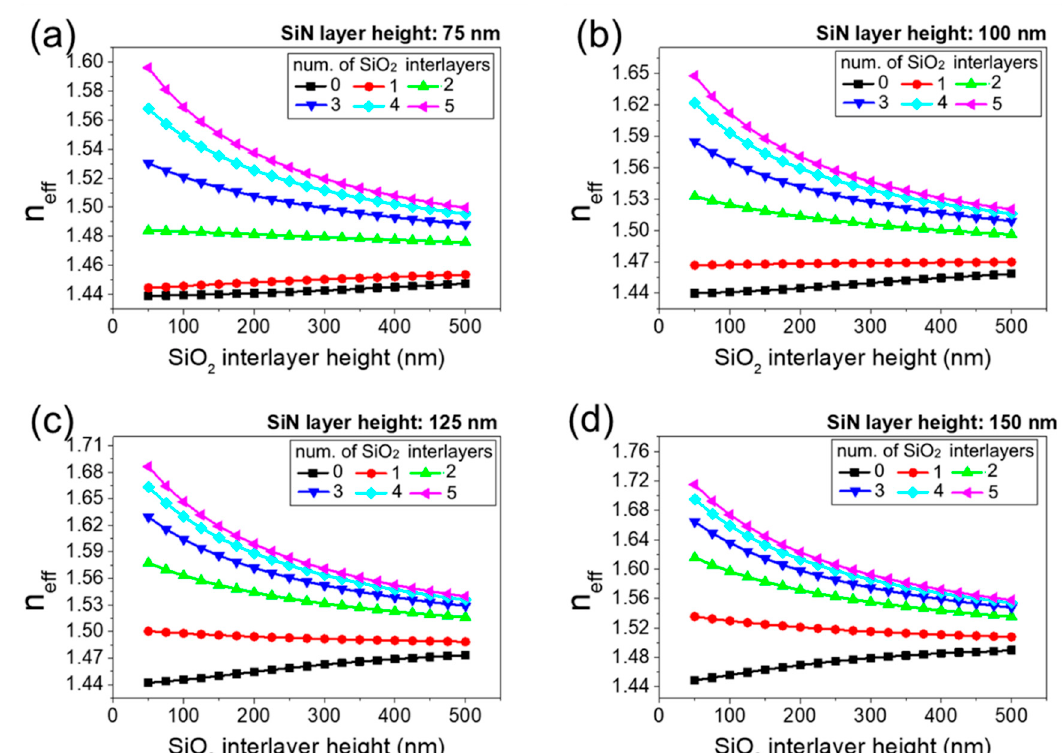
Figure 3. neff vs. SiO2 thickness at 1550 nm. Four SiN layer thicknesses: ( a ) 75 nm, ( b ) 100 nm, ( c ) 125 nm, and ( d ) 150 nm.